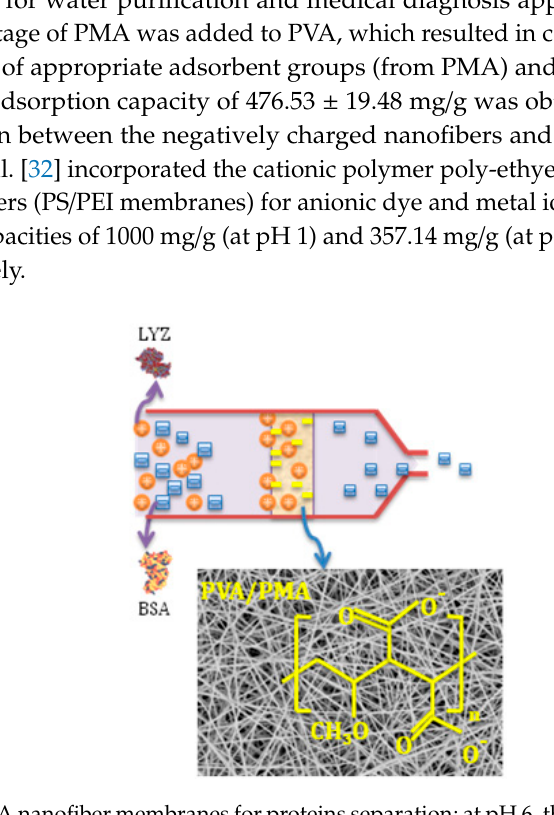
Figure 5. PVA-PMA nanofiber membranes for proteins separation; at pH 6, the charge of LYZ (IP of 10.8) is positive, while the charges of the BSA (IP = 4.8) and PVA / PMA nanofibers are both negative. Thus, the nanofibers repel the BSA and capture the LYZ, resulting in a selective protein adsorption from a mixture.